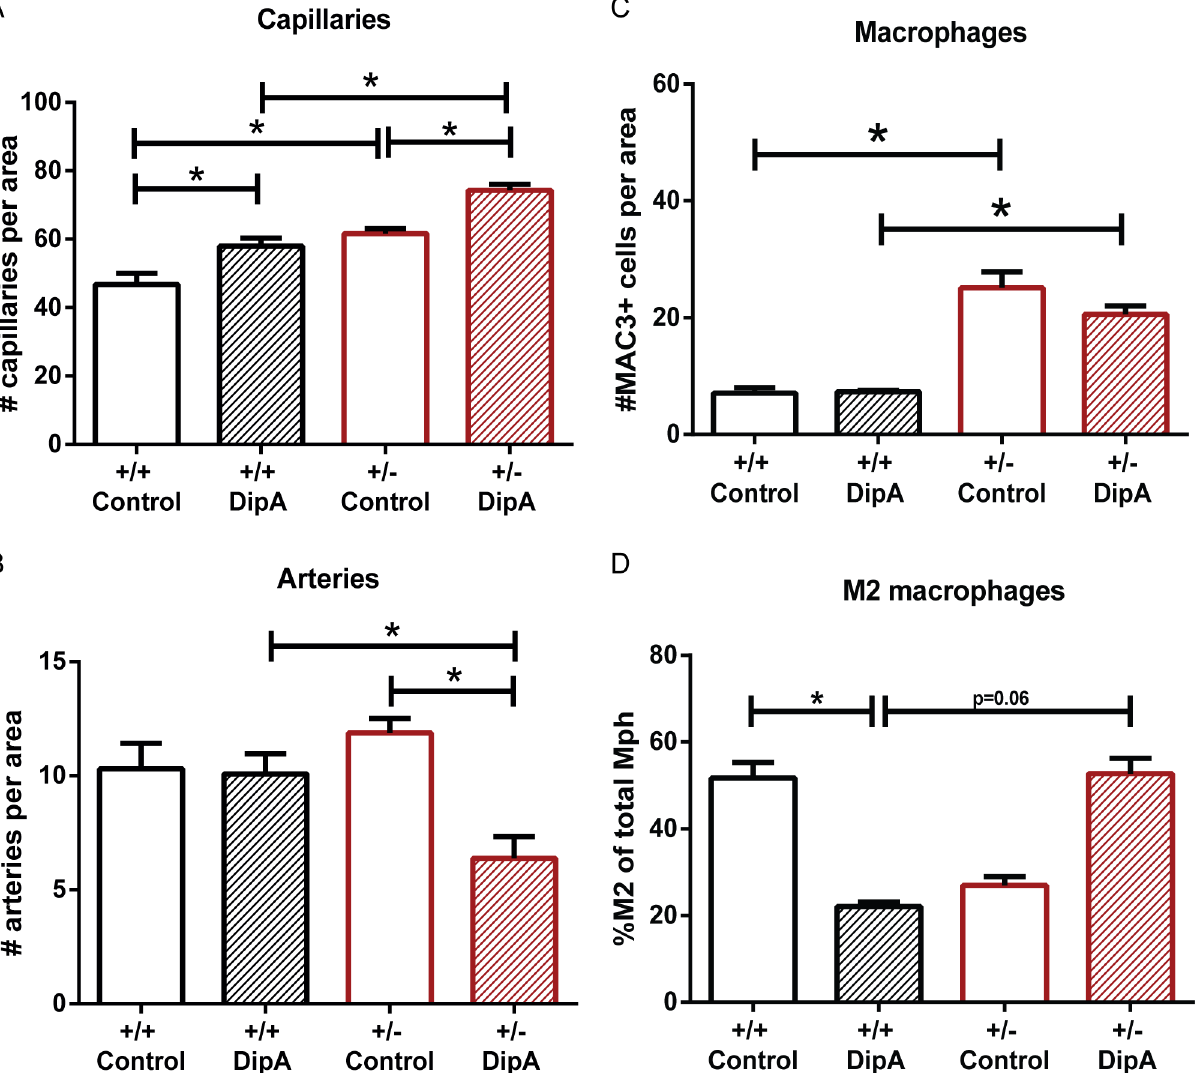
Fig 5. DPP4 inhibition affectsangiogenesis in the infarct border zone post-MI. (A) Capillaries in infarct border zone, day 14 post-MI. Quantification of PECAM-1 positive vessels per area (n = 4–6). Data shown are mean ± SEM, * P < 0.05. (B) Arteries in infarct border zone, day 14 post-MI. Quantificationof PECAM-1/ α SMA positive vessels per area (n = 4–6). Data shown are mean ± SEM, * P < 0.05. (C) Quantification of total macrophage (MAC3) number in day 14 post-MI hearts (n = 4–6). Data shown are mean ± SEM, * P < 0.05. (D) Quantification of MAC3 + /CD206 + (%M2) expressingcells in the infarct border zone 14 days post-MI (n = 3–6). Control = MQ treated, DipA = DiprotinA treated group. Data shown are mean ± SEM, * P < 0.05.